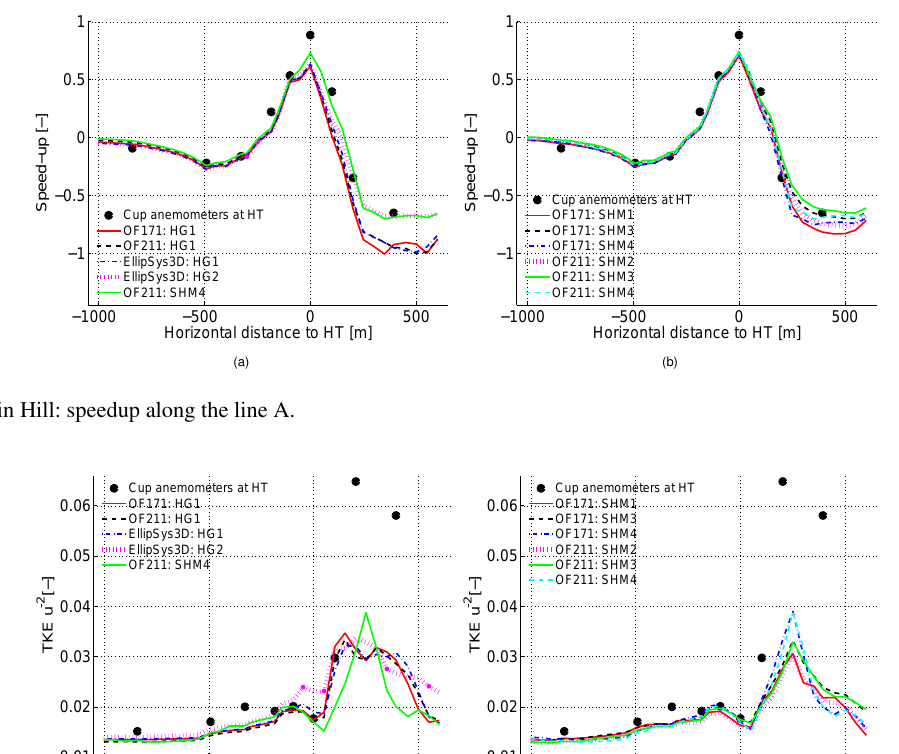
lations are carried out on HypGrid-based grids HG(1–2) and SnappyHexMesh-based grids SHM(1–4). In Figs. 4a and 5a EllipSys3D calculation on structured mesh HG1 and Open-